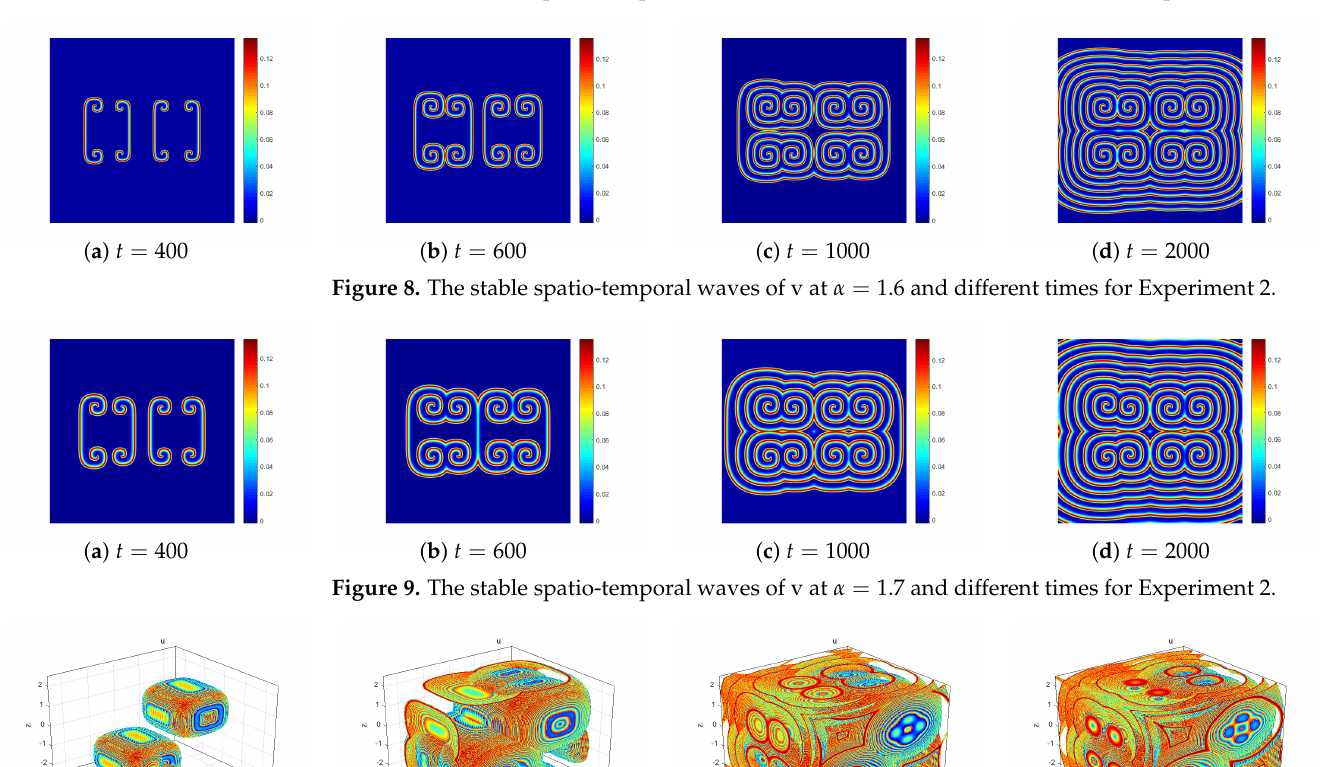
Figure 7. The stable spatio-temporal waves of v at α = 1.5 and different times for Experiment 2.